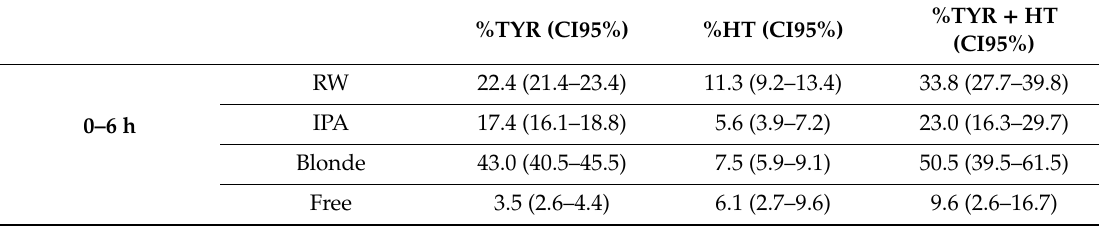
Table 5. Percentage of recovery for total TYR, total HT, and the sum of both compared to the dose of TYR administered (in µ moL) during the first 6 h post-administration of di ff erent treatments.